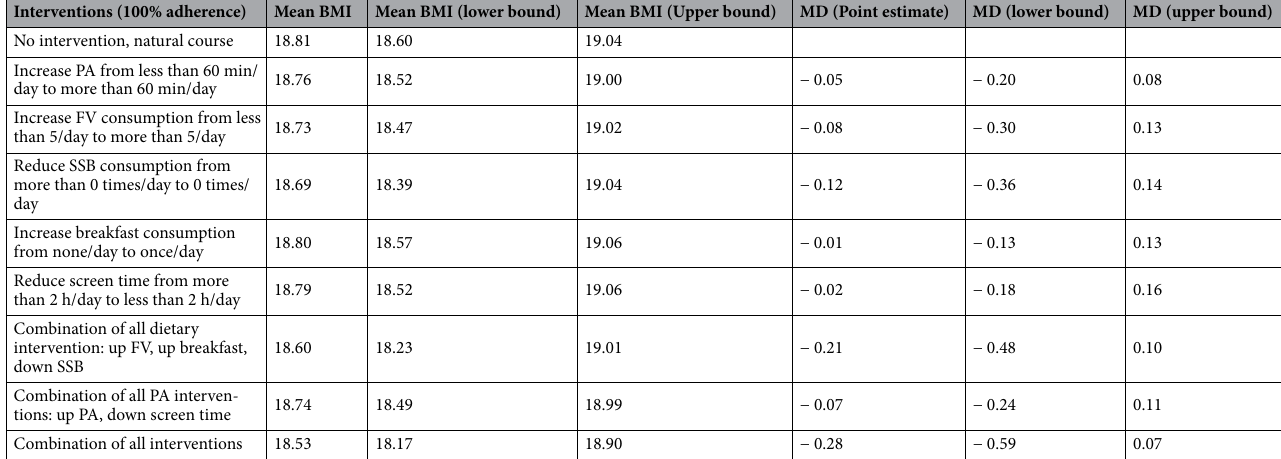
Table 2. Mean BMI at age 13 under interventions at age 11 and impact of different interventions in terms of mean differences (n = 530). Using 200 bootstrap samples, marginal structural model. Outcome of interest = BMI at age 13. Adjusted for age, puberty, sex, parental education, BMI at age 11. BMI body mass index, FV fruits and vegetables, MD mean difference, PA physical activity, SSB sugar-sweetened beverages.